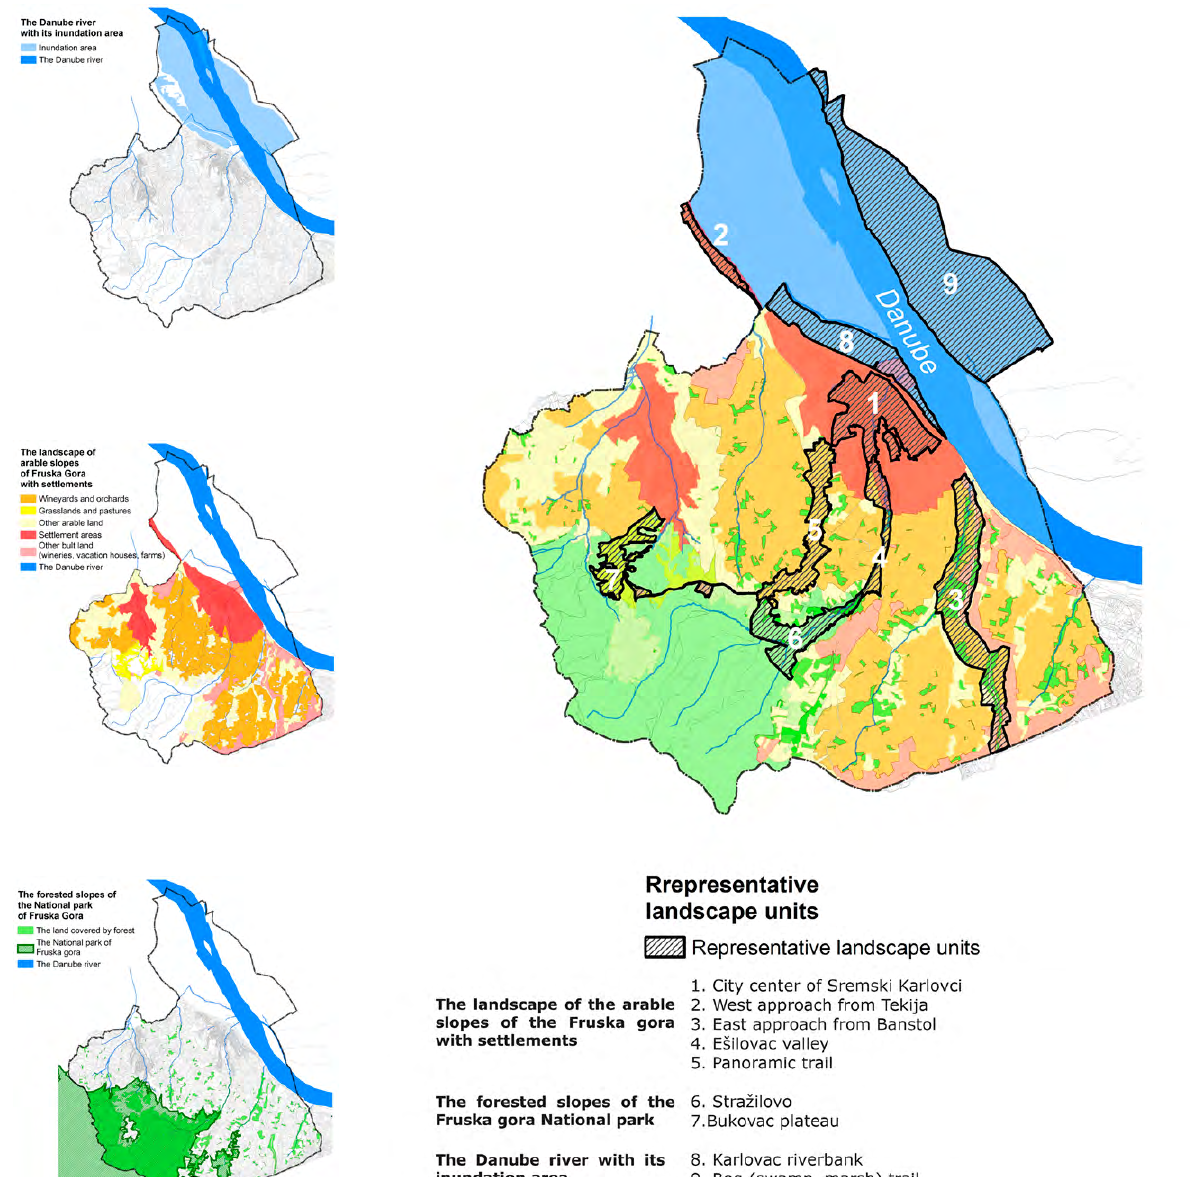
Figure 2. Landscape types and landscape units. Source: The map was created by authors from the GIS database used for the elaboration of the Spatial plan [click on figures to